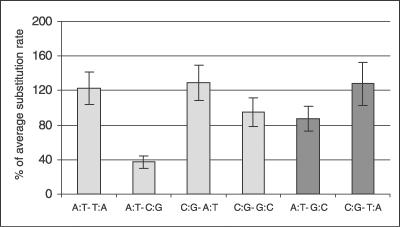
Neutral Point Substitution Pattern in Grasshopper Pseudogenes Accounting for Multiple SubstitutionsMaximum likelihood estimates of the frequency (with associated standard errors) of the different substitutions in grasshopper pseudogenes expressed as a percentage of the average substitution rate (C:G → T:A substitutions at CpG sites are excluded) (light grey, transversions; dark grey, transitions).